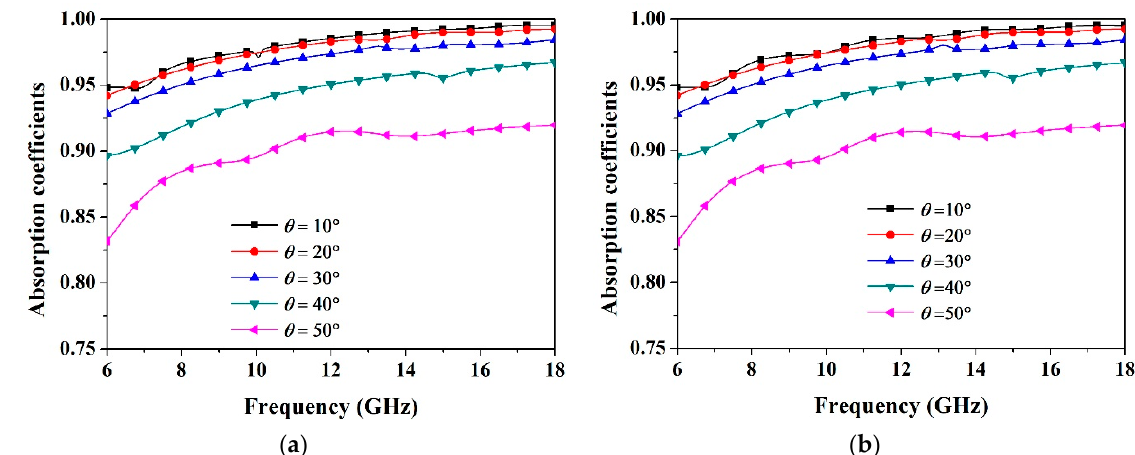
Figure 4. Absorption coefficients for oblique incidence θ . ( a ) TE mode. ( b ) TM mode.